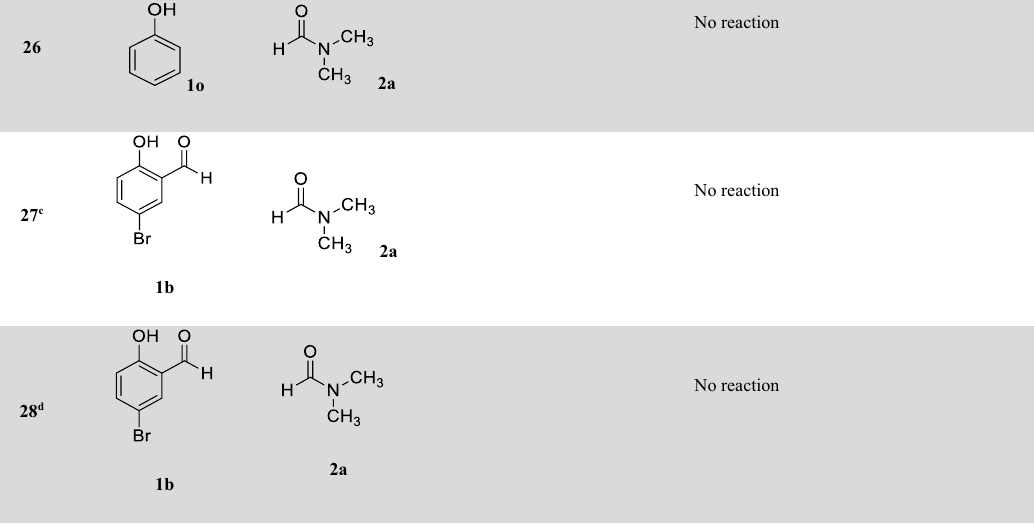
Table 2. Oxidative C–O coupling for the synthesis of carbamates catalyzed by Cu@Sal-CS a . a